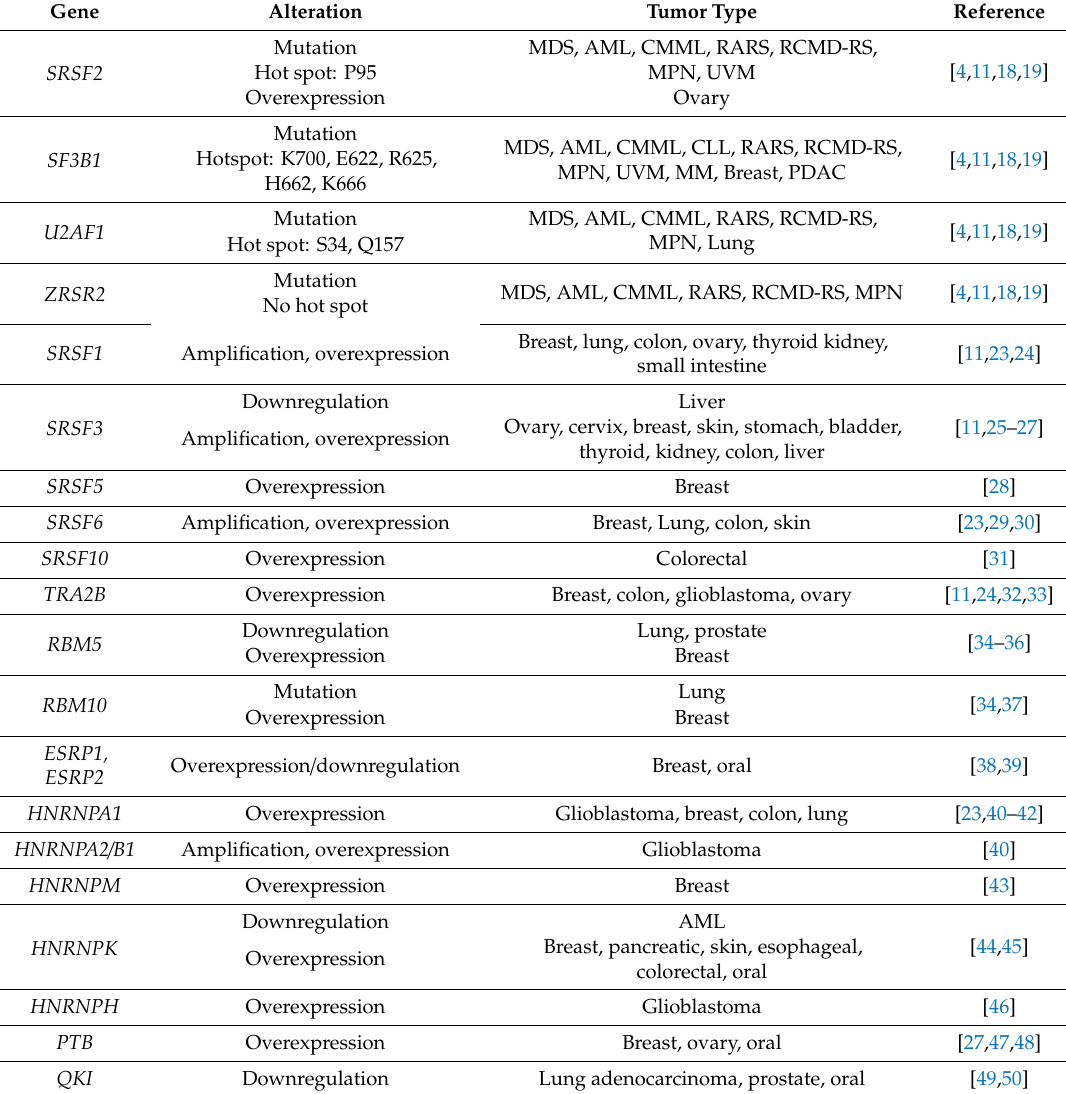
Table 1. Alterations in splicing factor in